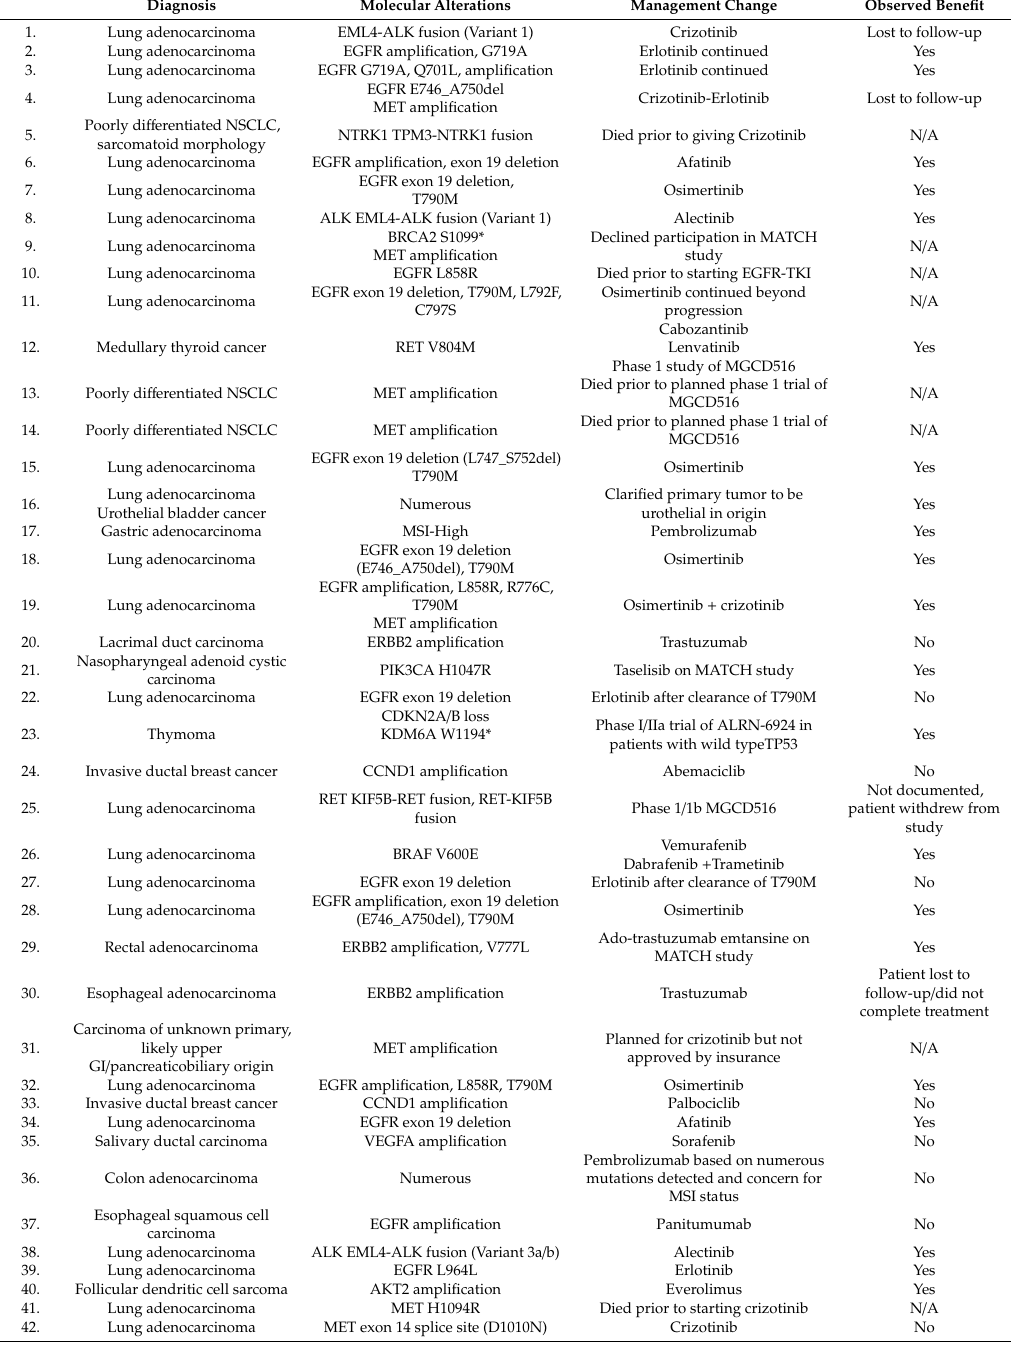
Table 3. Observed / proposed change in management based on comprehensive genomic profiling (*Documented response or on treatment for at least 3